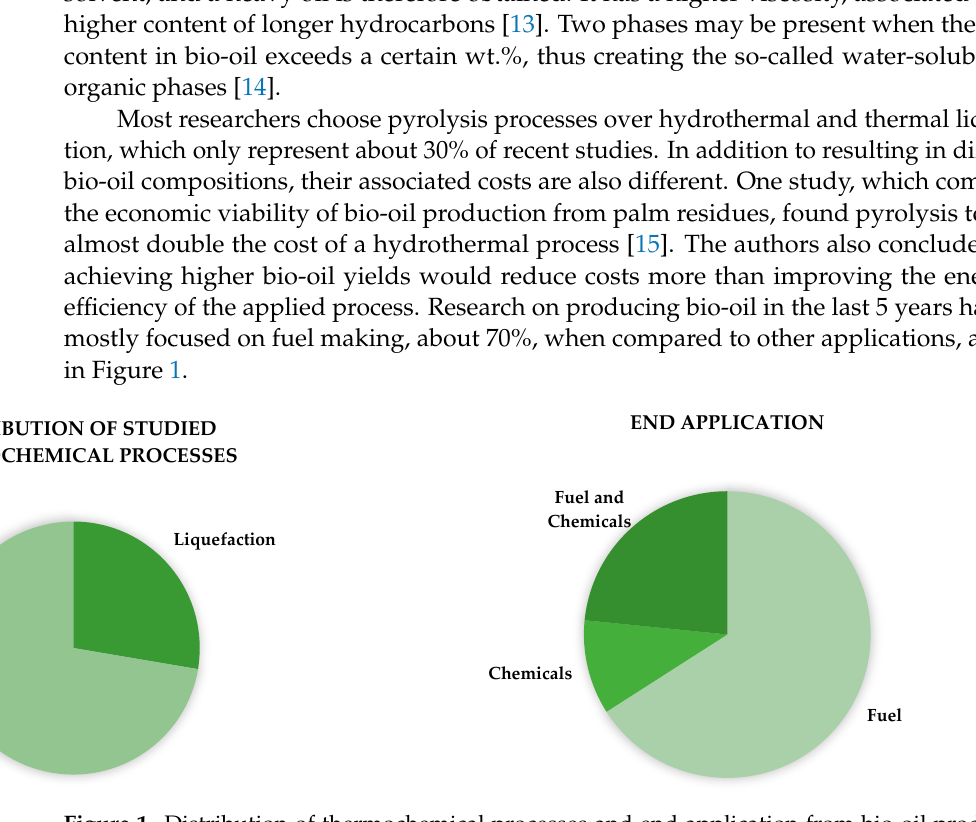
Figure 1. Distribution of thermochemical processes and end application from bio-oil production research in the last 5 years (according to a search made in Web of Science).